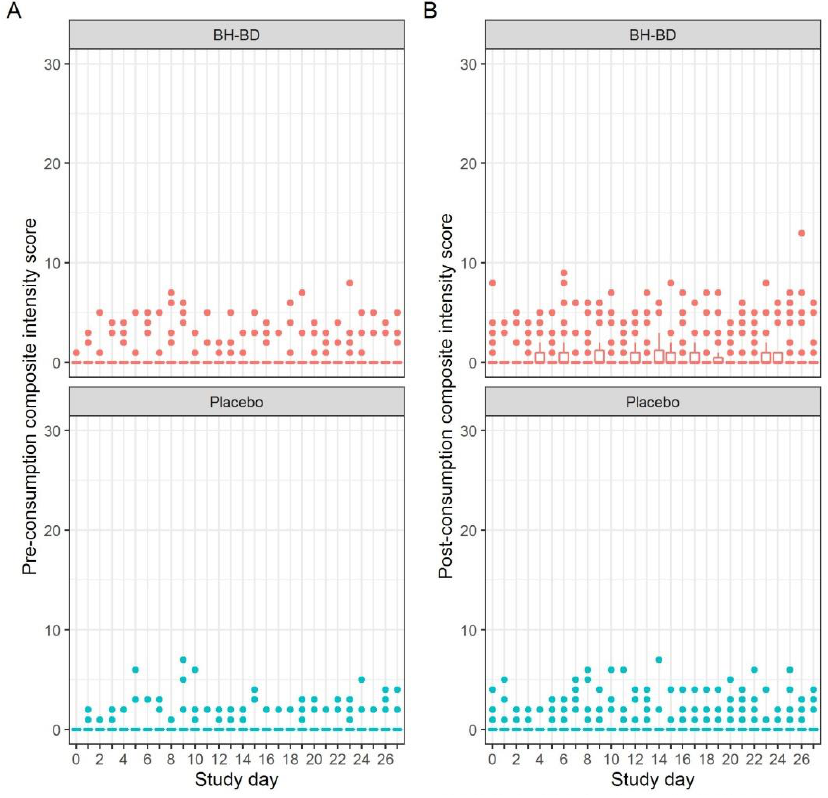
Figure 3. Daily beverage tolerability composite scores for healthy adults consuming up to 25 g/day of BH-BD or placebo. 10 tolerability issues (gas/flatulence, nausea, vomiting, abdominal cramping, stomach rumbling, burping, reflux/heartburn, diarrhea, headache, and dizziness) were scored 0 = none, 1 = mild, 2 = moderate and 3 = severe, giving a maximal composite score of 30. ( A ) Pre-beverage composite score; ( B ) Post-beverage composite score. Dots indicate statistical outliers identified by the 1.5 x interquartile (IQR) rule.